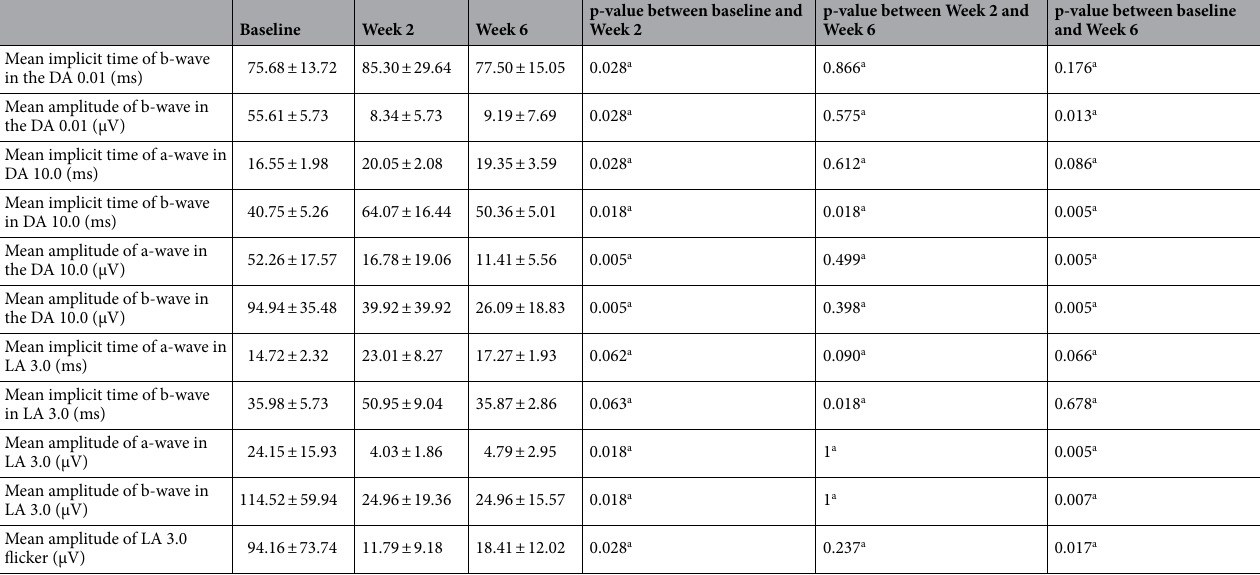
Table 1. The ffERG findings of the 5 mg/mL MNU group (n = 10). DA dark adaptive, LA light adaptive. a Wilcoxon-signed ranked